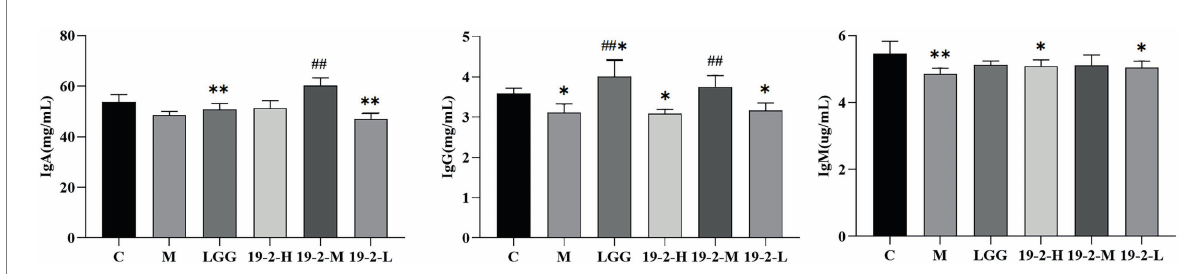
FIGURE 5 Amounts of IgA, IgG, and IgM in the blood of mice. **, * showed significant difference compared with the control group, p < 0.01, p < 0.05; ## represent significant difference compared with group M, p < 0.01.